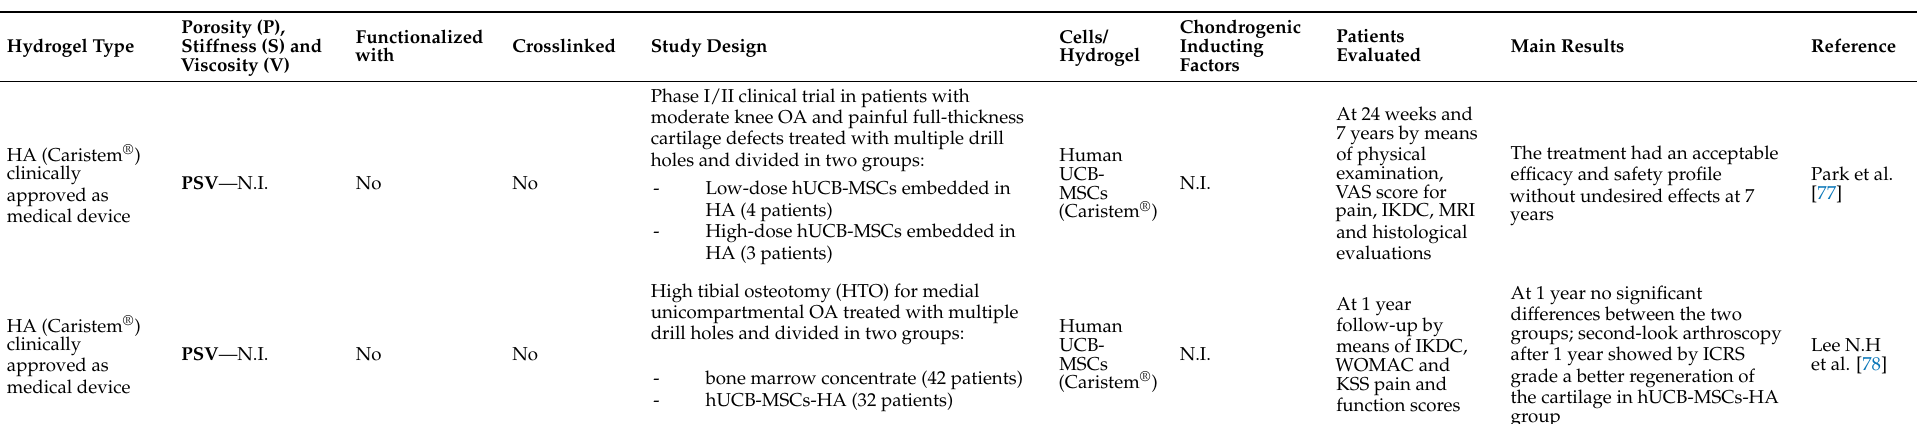
Table 4. Summary of the main results of selected clinical